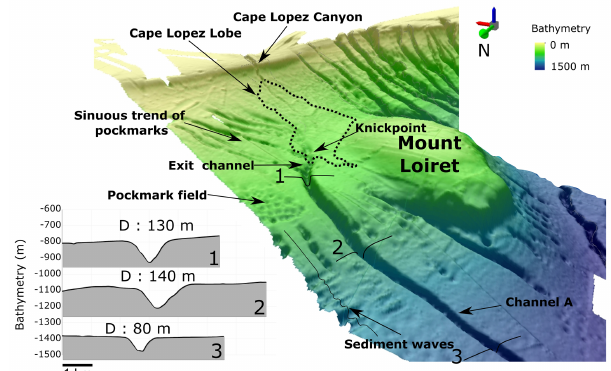
Figure 10. (a) Three-dimensional representation of the Cape Lopez Canyon, Cape Lopez lobe and channel A; (b) three transverse pro- files of channel A. (Vertical exaggeration: